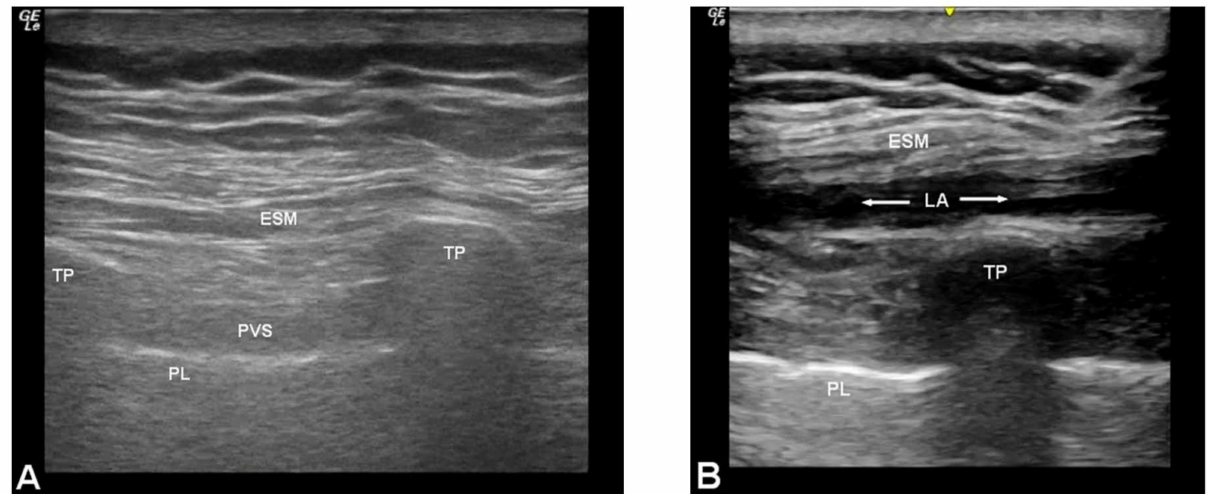
Figure 1. ( A ) Ultrasound anatomy of the erector spinae plane (ESP) prior to block placement. ( B ) Ultrasound demonstrating local anesthetic (LA) spread in the ESP. Abbreviations: ESM, erector spinae muscle; PL, pleura; PVS, paravertebral space; TP, transverse